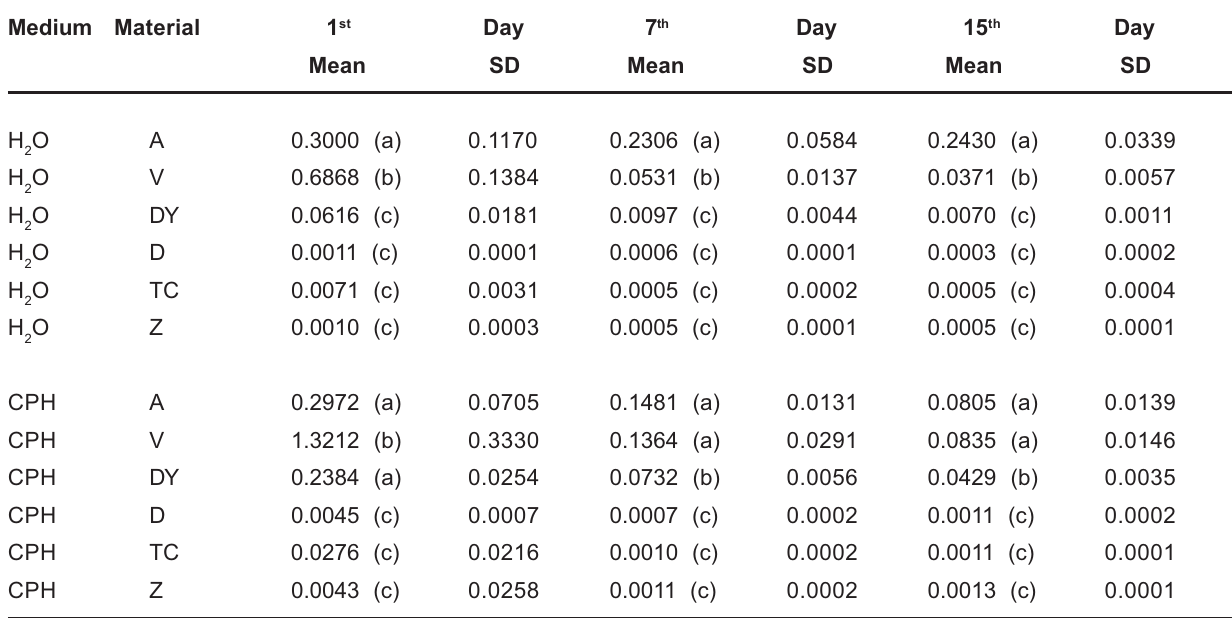
Materials with equal letters were not statistically significant.